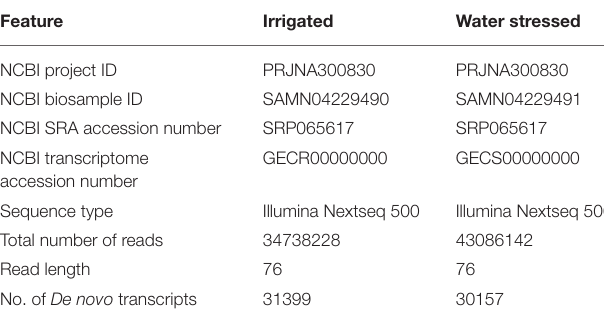
TABLE 1 | Zea mays Z59 transcriptome